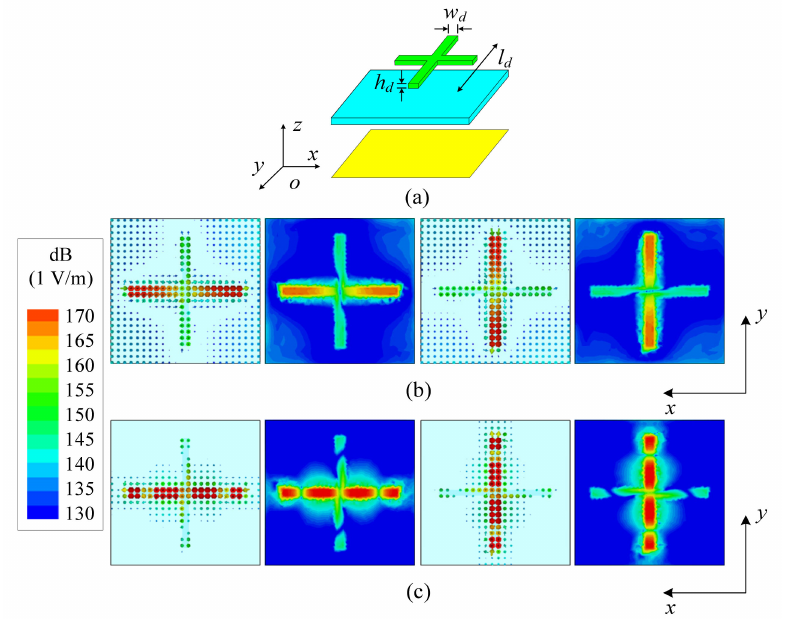
Figure 2. Configuration and E-field distributions of the cross-shaped dielectric strip resonator in xoy -plane: ( a ) configuration; ( b ) TM δ 1 mode; ( c ) TM δ 3